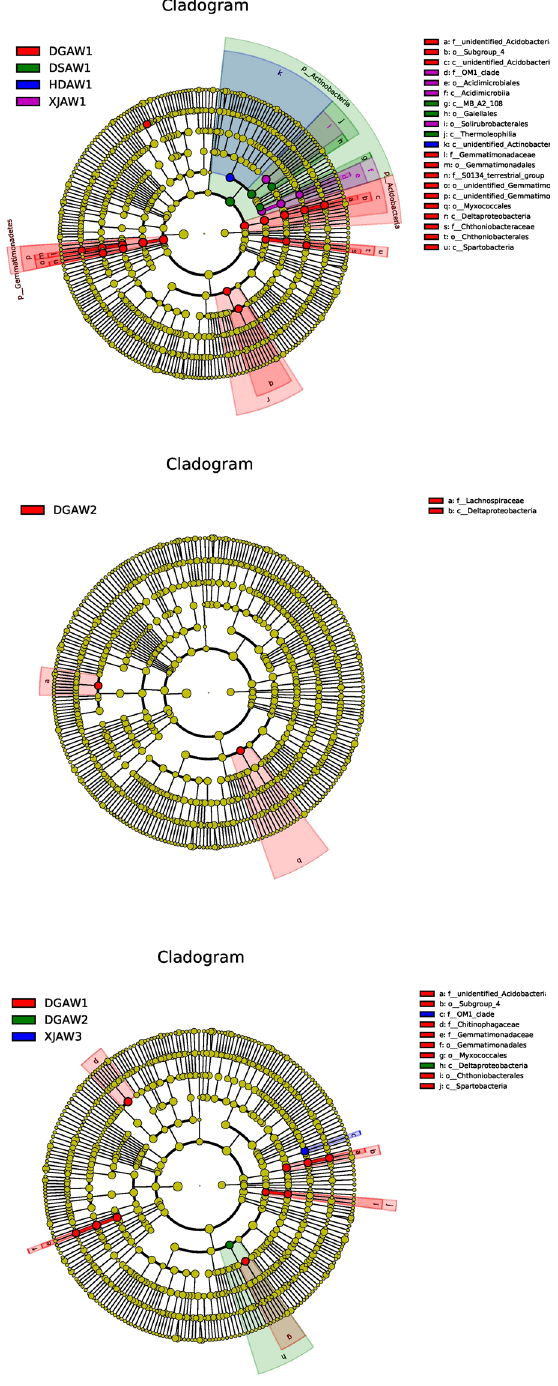
Figure 6. Cladograms indicating the polygenetic distribution of bacterial lineages in the rhizosphere of four Ferula species as determined by linear discriminant analysis (LDA) effect size (LEfSe). ( a ) The uppermost (3 cm) root depth; ( b ) the intermediate (20 cm) root depth; and ( c ) all root depths (3, 20, and 40 cm). Coloring principles: Species with no significant difference were uniformly colored yellow, the species of Biomarker were colored following the different group, the red node was the bacteria group that played an important role in the red group, and the green node was indicated to play an important role in the green group bacterial taxa. The name of the species represented by the English letters in the figure is shown in the illustration on the right. Abbreviations: HDAW, F. syreitschikowii ; XJAW, F. gracilis ; DSAW, F. ferulaeoides; and DGAW, F. lehmannii . The numbers indicate the root depth (1, 2, and 3 represent the 3, 20, and 40 cm depths, respectively). Indicators were defined as those with an LDA > 3. Red, green, blue, and purple circles represent bacterial biomarkers in F. lehmannii, F. ferulaeoides , F. syreitschikowii , and F. gracilis ,